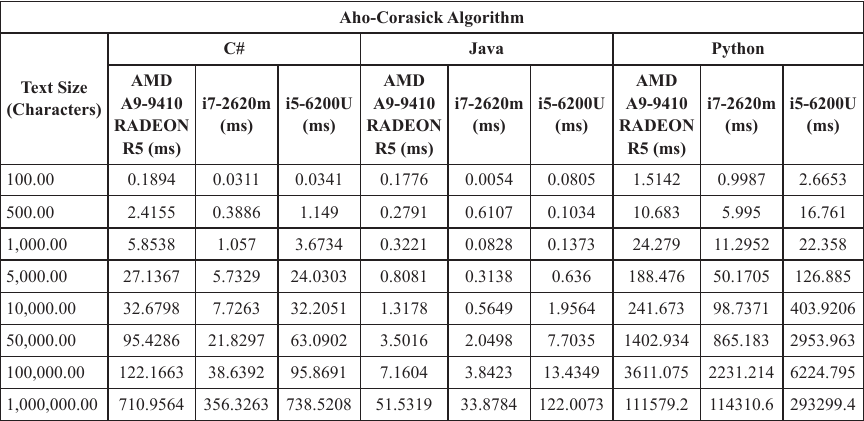
Table 7. Running time of Aho-Corasick algorithm in C#, Java